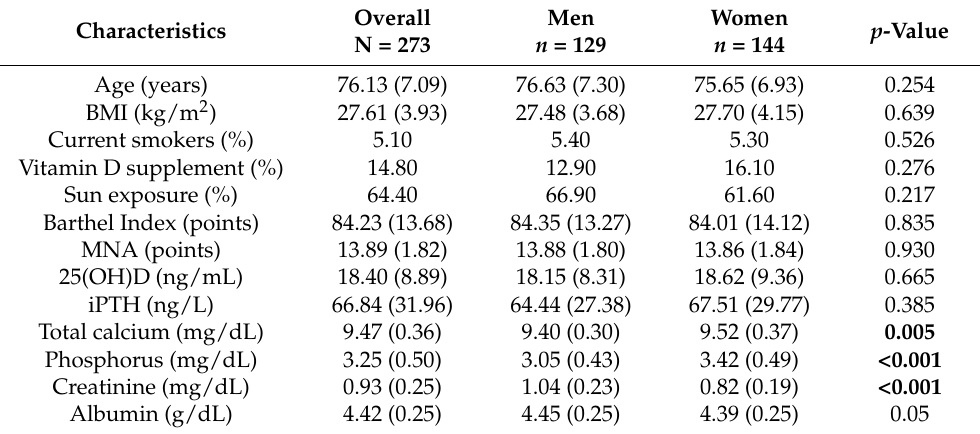
Table 1. Description of the study cohort.